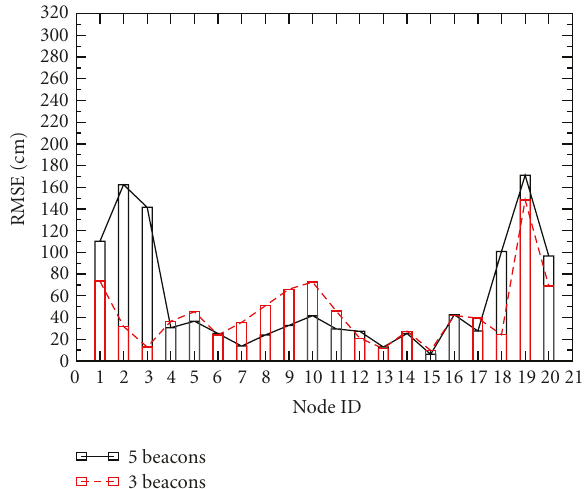
Figure 6: RMSE as a function of target position in the presence of priori information (two-step algorithm). N = 3 (tx1,tx3,tx5) and N =